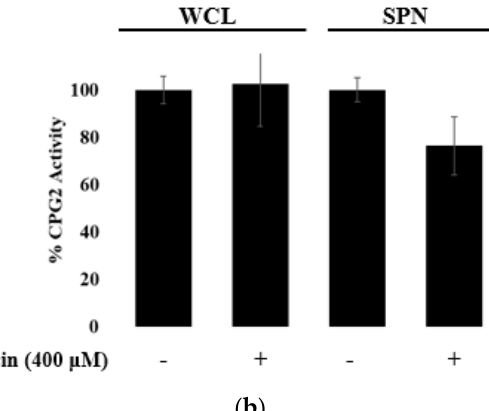
Figure 8. Regacin was analyzed for its ability to inhibit the T3SS-mediated secretion of CPG2. ( a ) At 40X the IC 50 (400 μ M), regacin was not able to abolish secretory activity entirely, confirming the ability of the CPG2-reporter assay to differentiate between partial and total inhibition of the T3SS. ( b ) To ensure this inhibitor of a global regulator was not inhibiting the expression of CPG2 from the plasmid, the activity of CPG2 in the presence and absence of regacin in whole-cell lysate (WCL) and supernatant (SPN) was analyzed. The activity of CPG2 in WCL was unchanged by the addition of regacin, indicating that this compound is not inhibiting the expression of CPG2. The activity of the enzyme is minorly inhibited in the SPN samples, indicating that secretion of the enzyme through the T3SS is being inhibited.